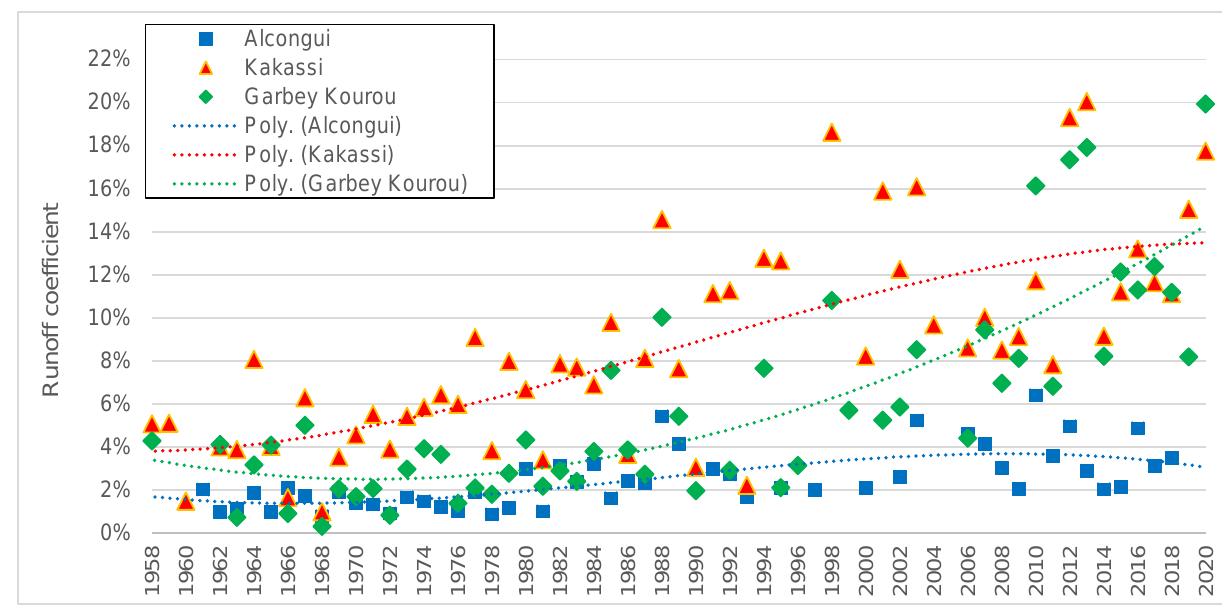
Figure 15. Runoff coefficients over the period 1958–2020 of the three main Sahelian tributaries: Gorouol River at Alcongui,